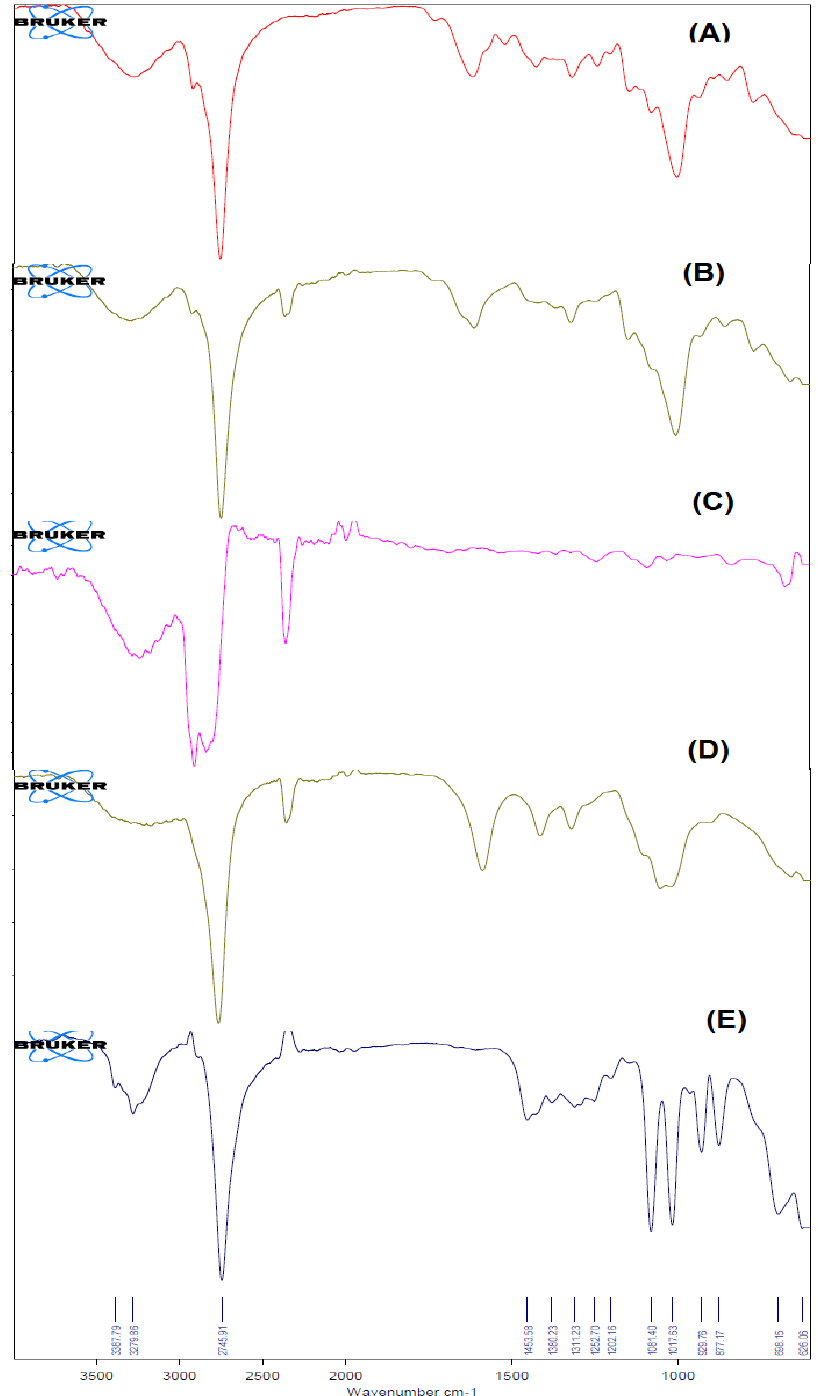
Figure 6. The FT–IR Spectra of Erlo ( A ), cinnamon polymer ( B ), polyvinyl alcohol ( C ), Dox–Erlo NPs ( D ), and Dox–Erlo NP conjugates ( E ).